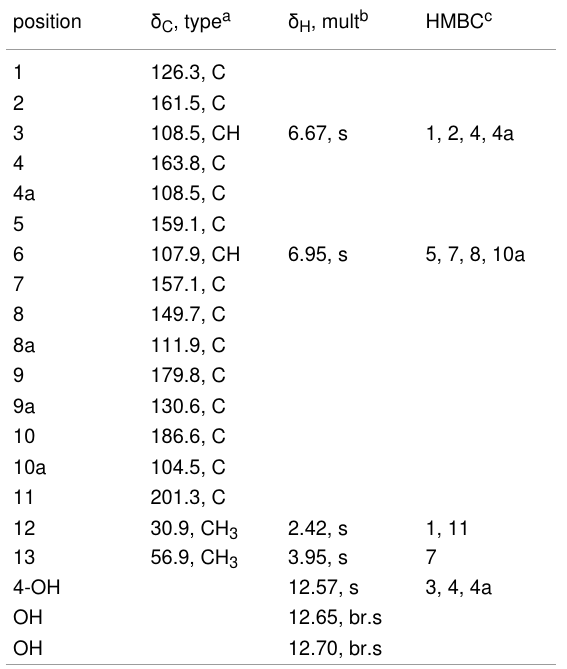
Table 1: NMR spectroscopic data for karimunone A ( 1 ) in DMSO- d 6